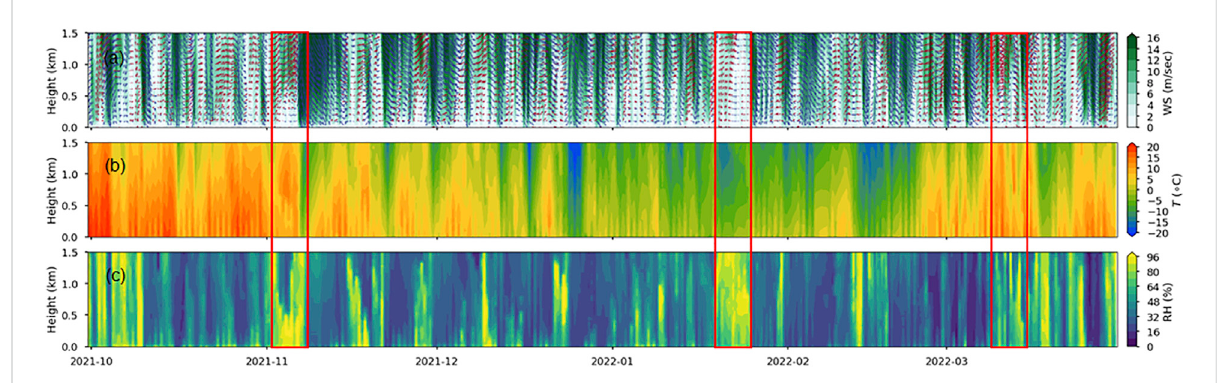
FIGURE 3 Time series of vertical distribution of meteorological factors including (A) wind speed; (B) temperature (T); and (C) relative humidity (RH) from 25 October 2021 to 22 March 2022; the solid red line represents the three polluted